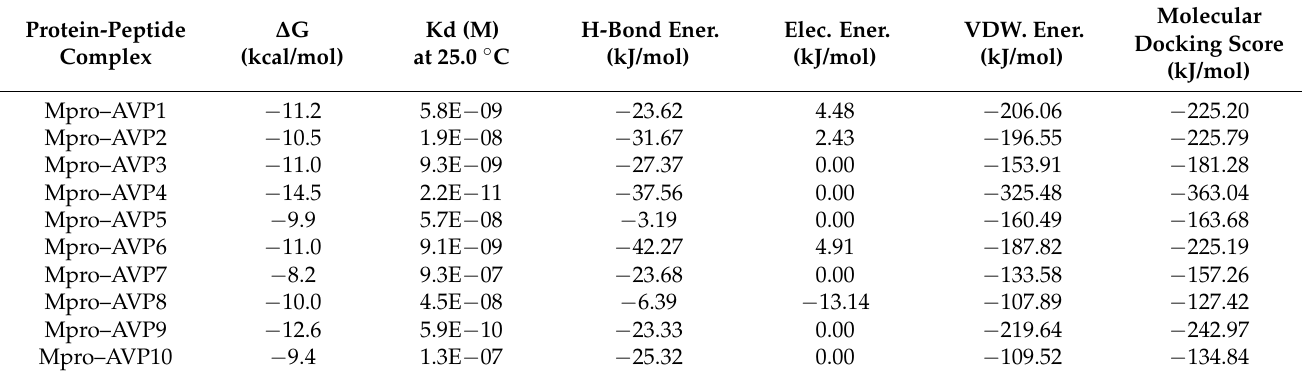
Table 4. Calculated binding affinity ( ∆ G), dissociation constant (Kd), and binding energy scores from the molecular docking of ten peptides (AVP1 to AVP10) to the SARS-CoV-2 main protease based on the PROGIDY and PIMA web servers. Molecular docking scores, H-bonds, electrostatic energy, and van der Waals energy (H-bond Ener., Elec. Ener., and VDW. Ener.) are presented in